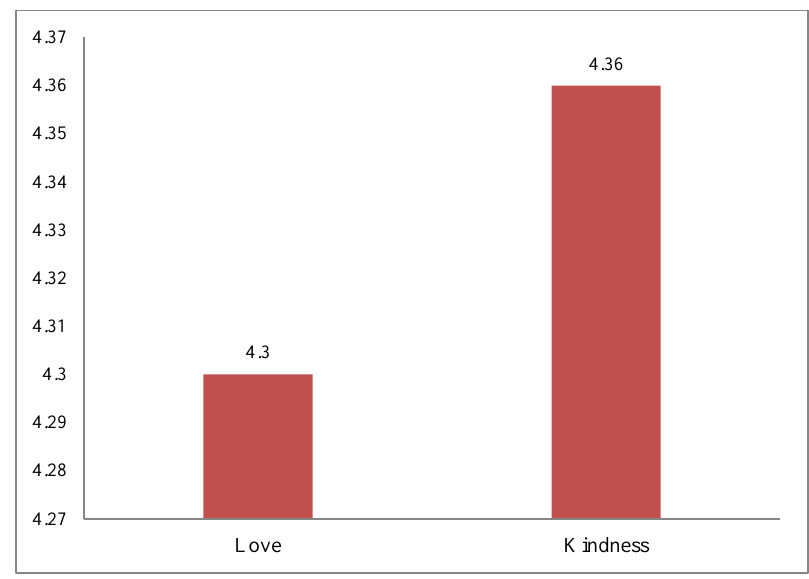
Fig. 4. 3rd virtue: Humanity (means, rated on a 5-point scale,